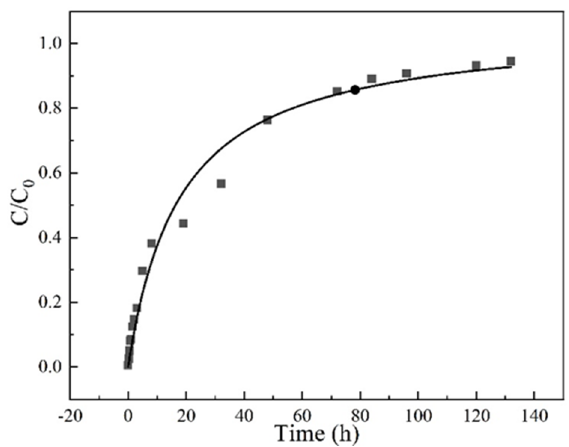
Figure 8. The homogeneous surface diffusion model (HDSM) diffusion model fitted breakthrough curve Experiment condition: sulfamethoxazole concentration of 35 mg/L, flow rate of 3 mL/min, pH 6.5, column height 3 cm.